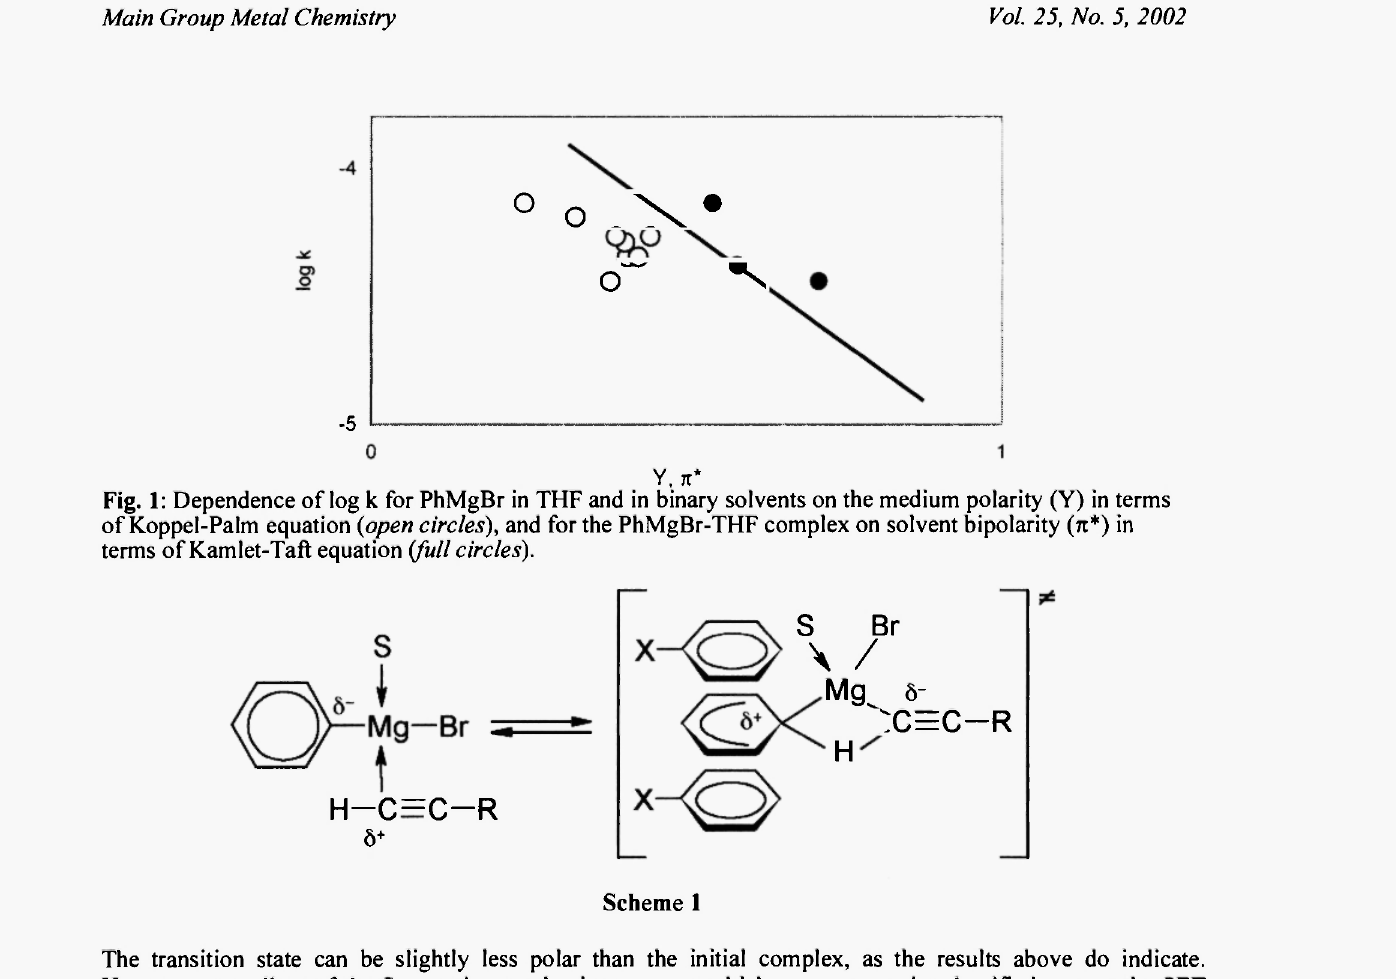
Fig. 1: Dependence of log k for PhMgBr in THF and in binary solvents on the medium polarity (Y) in terms of Koppel-Palm equation ( open circles), and for the PhMgBr-THF complex on solvent bipolarity (π*) in terms of Kamlet-Taft equation {full